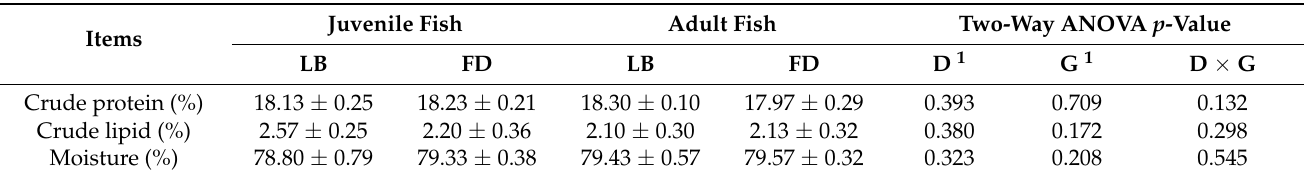
Table 4. Effects of live baits and formulated diet on the proximate composition in muscle of Siniperca chuatsi at different growth stages 1 .